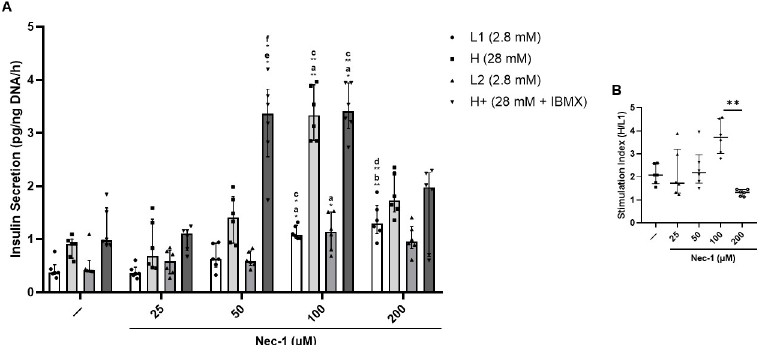
Fig 8. Glucose-stimulated insulin secretion in islets after 7 days of tissue culture in control media (—) or media supplemented with 4 different doses of necrostatin-1 (25, 50, 100, or 200 μ M of Nec-1) on day 3. 100 islet equivalents were incubated at 37˚C and 5% CO 2 in the following order of glucose media for 1 hour each: 2.8mM (L1), 28mM (H), 2.8mM (L2), and 28mM + 0.1mM IBMX (H+) glucose media. The insulin concentration in each media was measured using ELISA and normalized to the DNA content of each islet sample. Glucose-induced insulin stimulation index was calculated as the ratio of insulin content in H media over L1 media. A) Insulin secretion per hour in response to glucose challenge. B) Islet glucose-induced insulin stimulation index. n = 6 for each group. a.—vs 100. b.—vs 200. c. 25 vs 100. d. 25 vs 200. e.—vs 50. f. 25 vs 50. � p < .05. �� p < .01. Data are expressed as median and interquartile